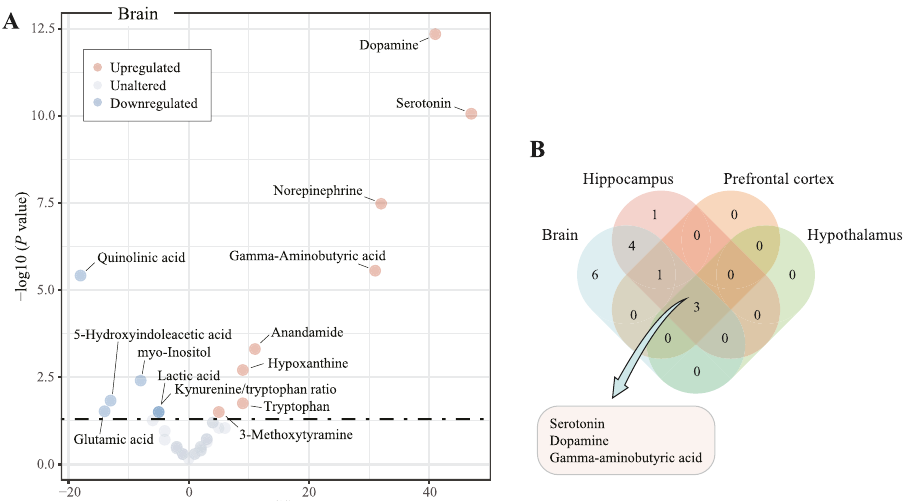
Fig. 1 Effects of pharmacological treatment on metabolite alterations in the brain of depression models. A Volcano plot for consistently upregulated (red) and downregulated (blue) metabolites across studies. Dysregulated metabolites were identi fi ed by vote-counting procedures with a signi fi cance threshold of one-tailed P < 0.05. The vote-counting statistic (VCS) is presented on the x -axis and the − log10 ( p value) is presented on the y -axis. B Venn plot for shared dysregulated metabolites between the brain, hippocampus, prefrontal cortex, and